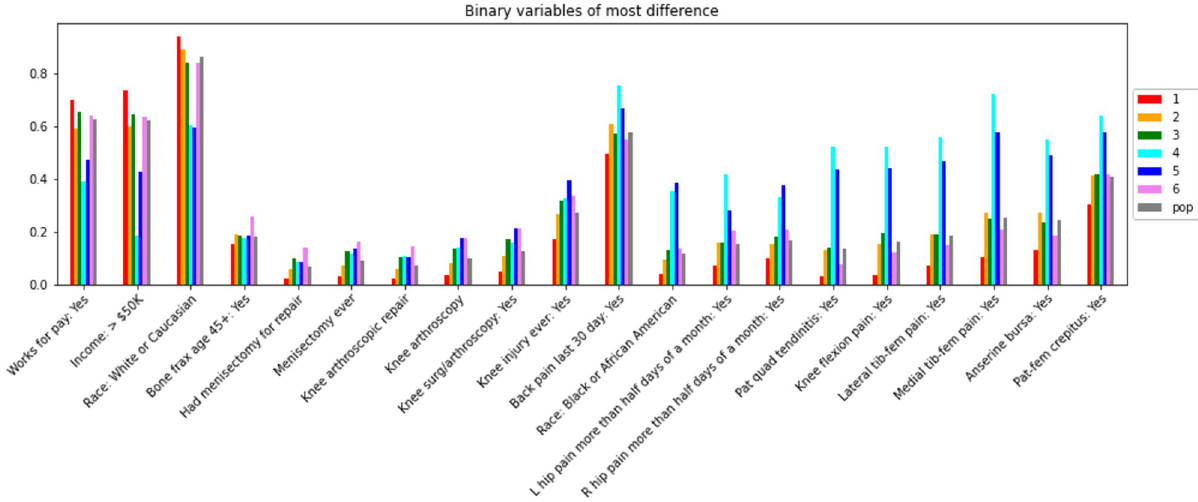
Fig 4. Bar plot comparing key binary variables across the 6 biclusters and the overall population of knees (pop). The y-axis indicates the proportion in each category of the variables (which are shown on the x-axis). Bars are colored by bicluster number, with the overall population of knees (pop) in